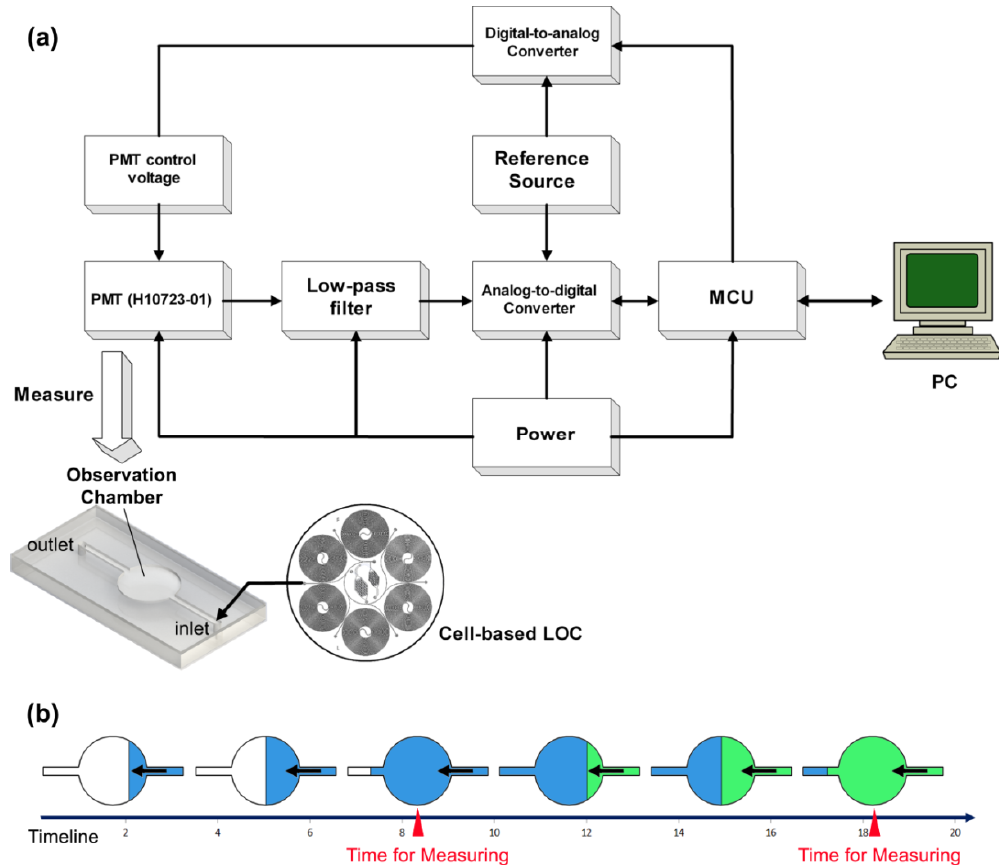
Figure 3. Schematic of the detection system. ( a ) The droplet flow is generated by the cell- based LOC and moved into the observation chamber. The H10723-01 PMT is located on top of the observation chamber to collect the luminescence. The control voltage of the PMT is programed by a DA converter (Analog Devices, Inc. ® ). The voltage output of PMT passes through a low-pass filter to improve the signal-to-noise ratio before AD conversion, the activity of which is controlled by a microcontroller unit (Texas Instruments Inc. ® , Dallas, TX, USA). The digital signals are transported into a computer (PC) through the USB interface. ( b ) Dynamic diagram of the observation chamber. The droplets flow from the cell-based LOC through the observation chamber continuously. After a short period, the contents of the observation chamber are totally replaced. Accordingly, the detection system measures the observation chamber